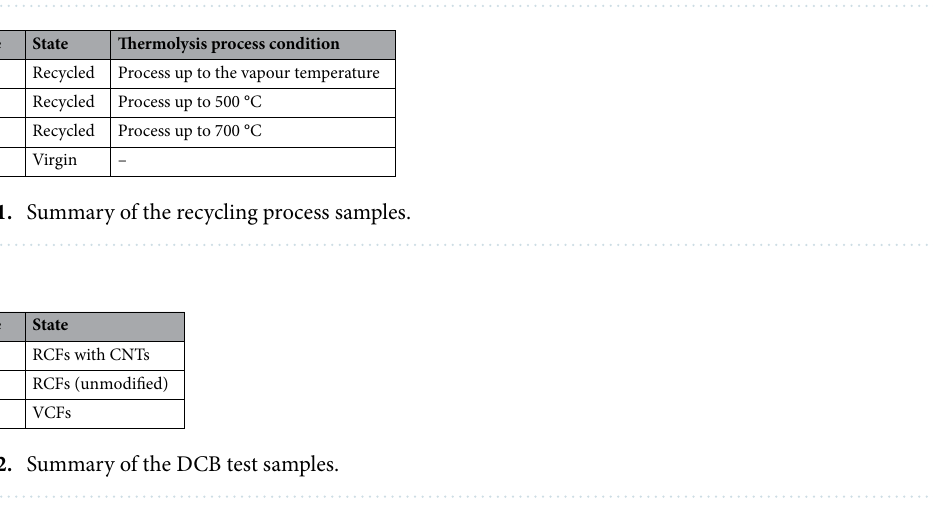
Figure 1. Poptube process scheme, decomposition of a carbon source and growth of microwave-assisted CNTs.